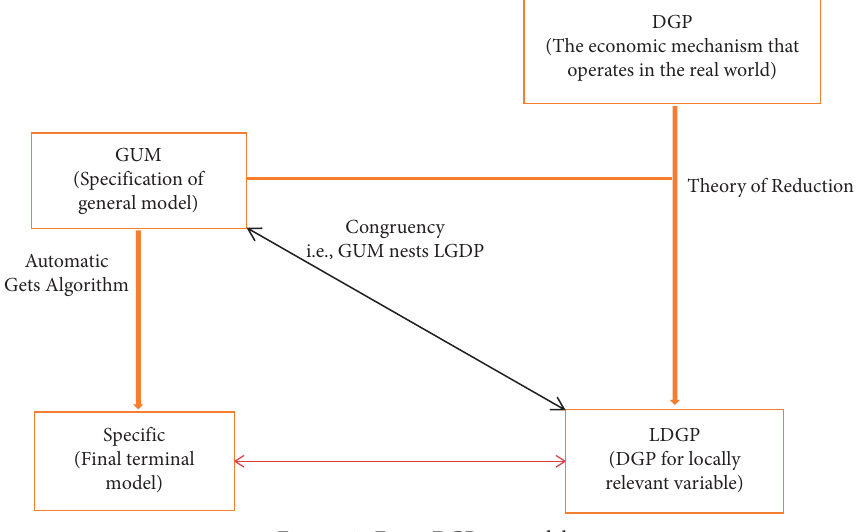
Figure 1: From DGP to